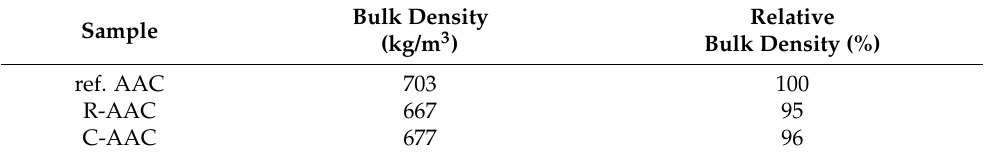
Table 3. The bulk density of AAC